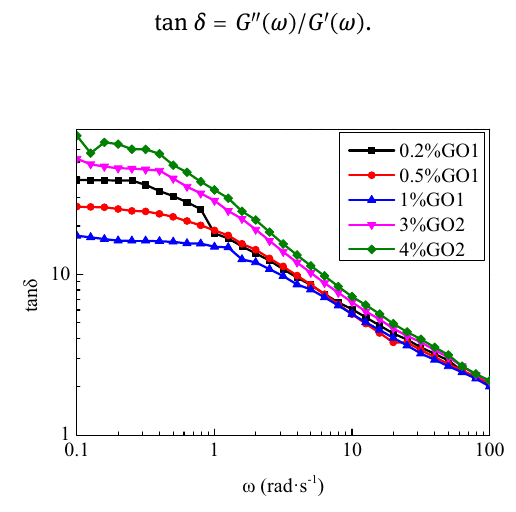
Figure 11: tan δ ∼ ω curves of blended solutions with di ff erent GO contents.